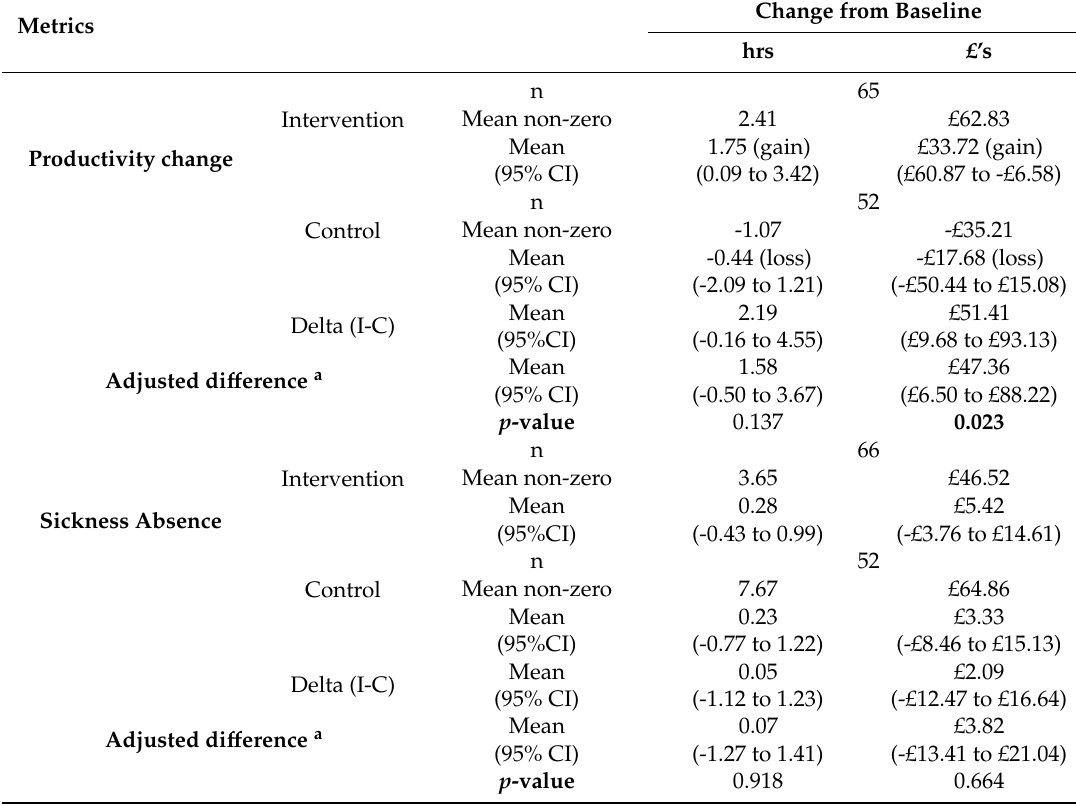
Table 3. Self-reported productivity change and absenteeism due to health